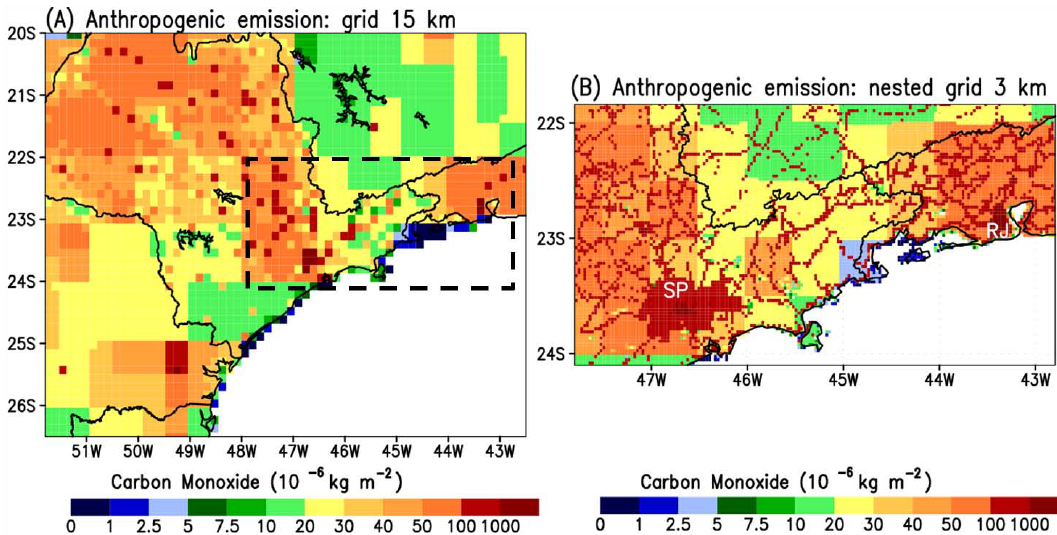
Fig. 4. Carbon monoxide anthropogenic emission field generated by the PREP-CHEM-SRC program: Panel (A) for a regional grid with 15km horizontal resolution, Panel (B) for a nested grid with 3km. The black box on Panel (A) represents the location of the nested grid in the coarse